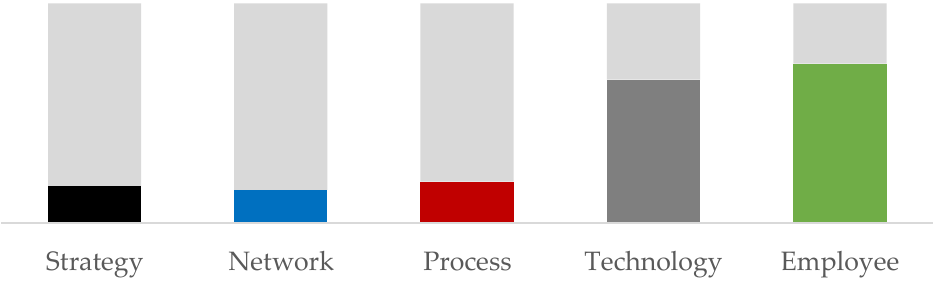
Figure 10. Level of the five logistics dimensions for the area-specific intermediate profile.